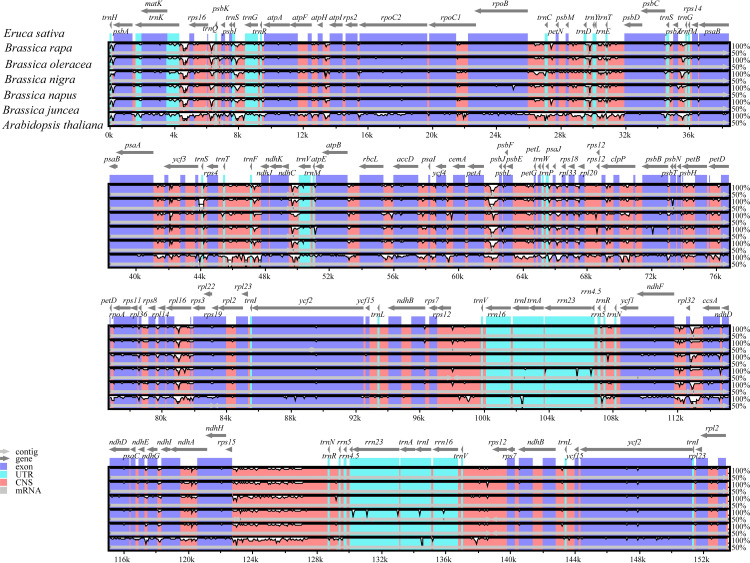
Sequence alignment of seven cp genomes of Brassicaceae by mVISTA, with the annotation of E. sativa as the reference.The vertical scale indicates the percentage of identity, ranging from 50% to 100%. The horizontal axis indicates the coordinates within the chloroplast genome. Genome regions are color coded as protein-coding, rRNA, tRNA, intron, and conserved noncoding sequences.